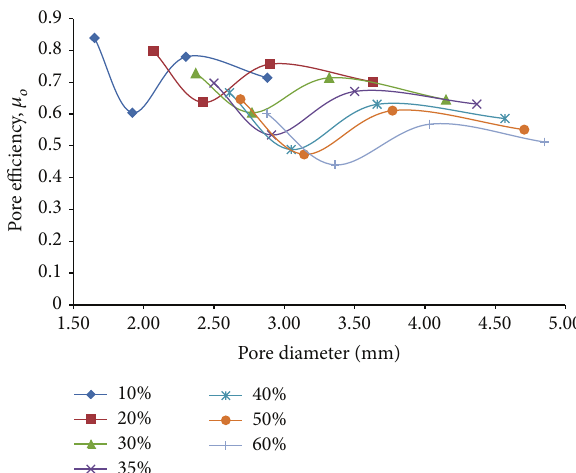
Figure 16: Plots depicting variation of pore efficiency under com- bined loading, 𝜇 𝑜 , against pore diameter for different percentages of porosity of 3D porous FE cantilever beam models subjected to combined loading